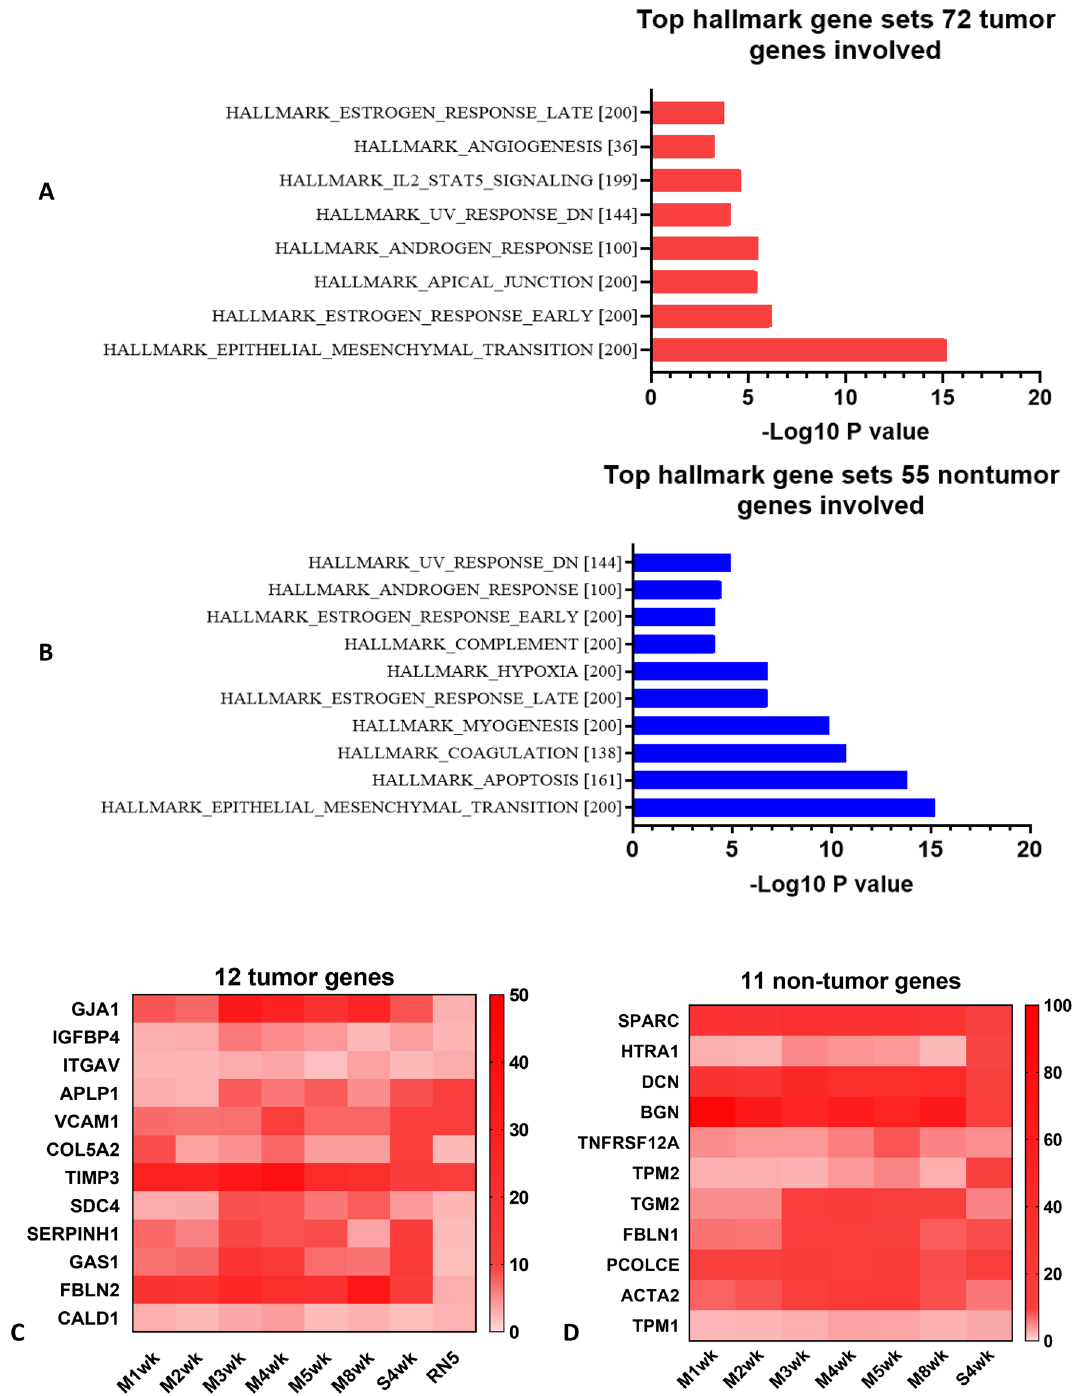
Figure 2. Epithelial–mesenchymal transition (EMT) is the top hallmark gene set in both tumor and non-tumor cell genes determined by GSEA. ( A , B ) 12/72 tumor genes and 11/55 non-tumor genes are involved in epithelial mesenchymal transition (EMT) pathway, identified by http:// www. gsea- msigdb. org/ gsea/ msigdb. Top hallmark gene sets were presented in bar graphs. ( C , D ) Gene expression in heatmap: 12/72 tumor genes and 11/55 non- tumor genes. Gene set enrichment analysis (GSEA) was computed to identify the overlaps with hallmark gene sets in Molecular Signatures Database (MSigDB) Collections. with FDR q-value less than